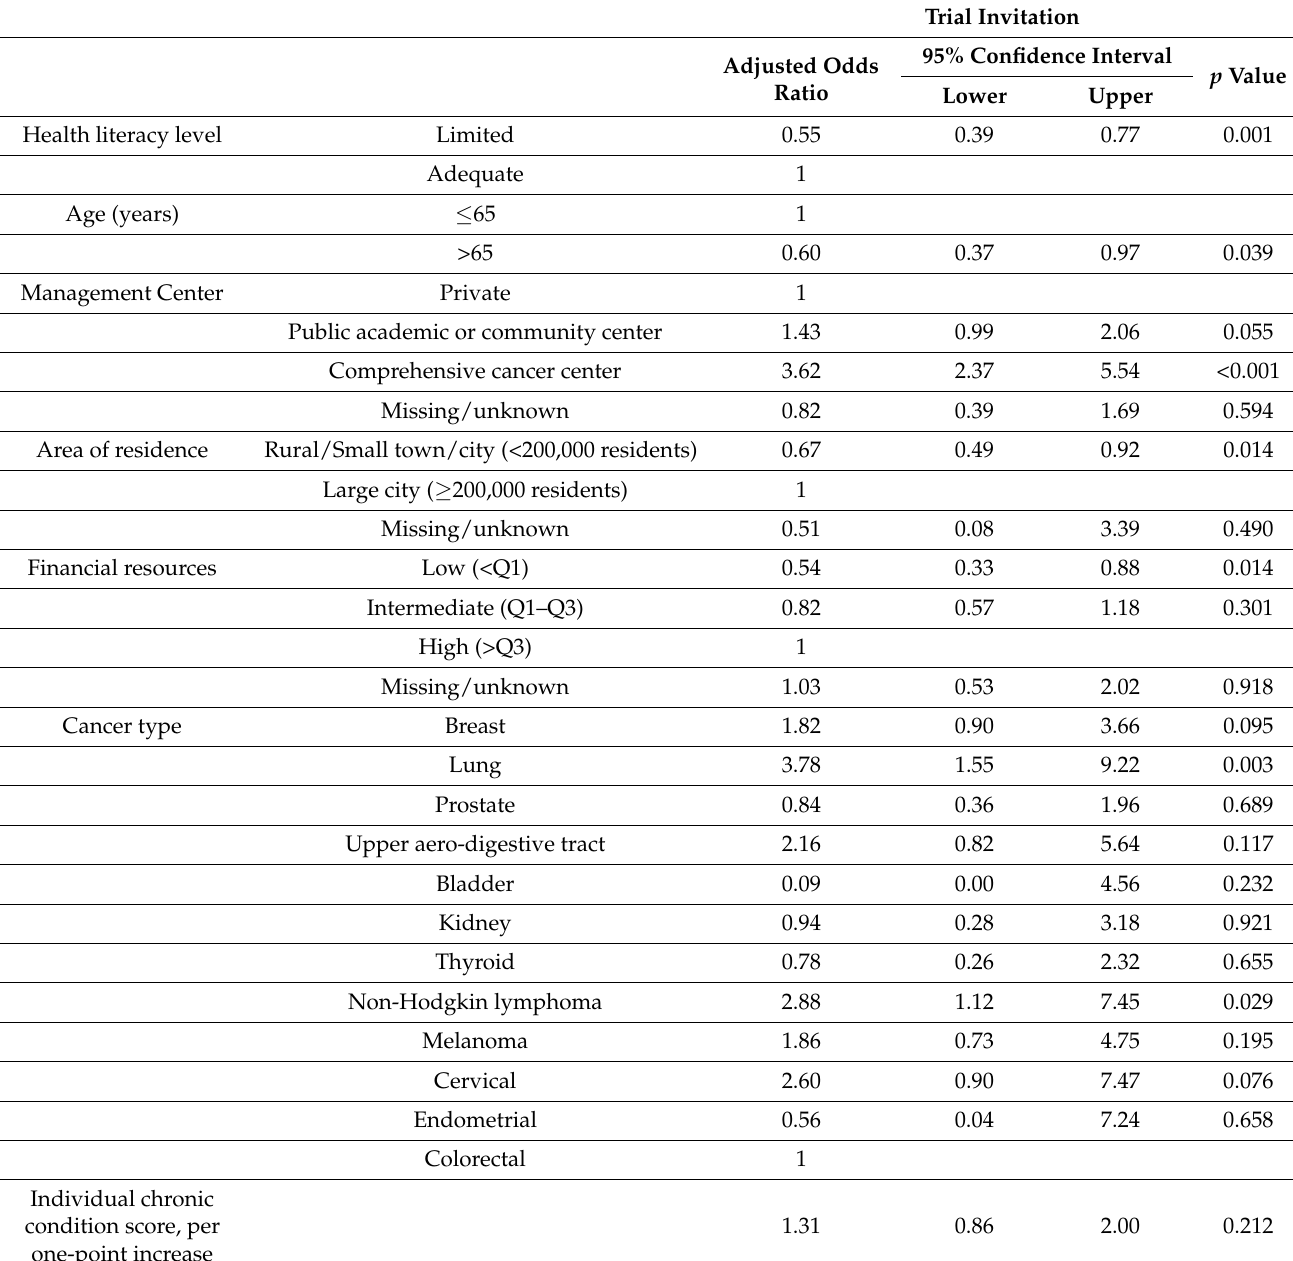
Table 2. Variables associated with the invitation to participate in a clinical trial (binary logistic regression, N =